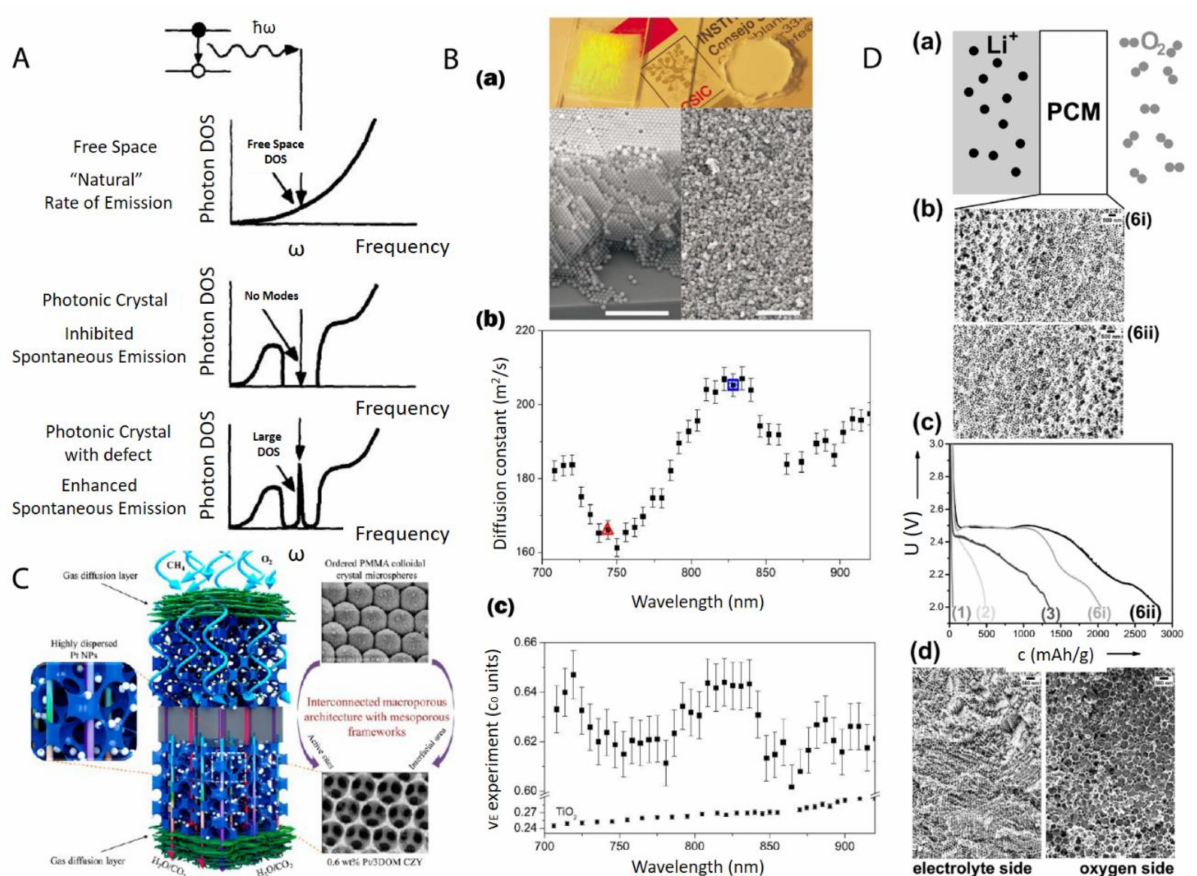
Figure 15. ( A ) Photon density of states (DOS) in free space, a photonic crystal, and a photonic crystal with a local defect. A perfect photonic crystal inhibits spontaneous photon emission within a band gap centered at a frequency ω while the spontaneous photon emission can be enhanced dramatically at frequency ω by a localized point defect in the colloidal crystal; ( B ) ( a ) Top: picture shows a photonic crystal (left), which shows visible iridescences and a photonic glass (right) white and without any iridescences. Bottom: Left is the SEM image from a photonic crystal (scale bar is 10 µ m) while Right is the SEM image from a photonic glass (scale bar is 10 µ m); ( b ) Experimental diffusion constant in a photonic glass made of PS spheres. Two particular wavelengths are marked with a triangle ( λ 1 = 744 nm) and a square ( λ 2 = 828 nm). These two wavelengths correspond to the maximum and minimum value of a Mie resonance; ( c ) Experimental values of the energy velocity ( ν E ) as a function of the wavelength ( λ ) for a photonic glass made of PS spheres and for TiO 2 powder. For the photonic glass, a full oscillation of around 5% amplitude is illustrated, while for the TiO 2 powder, a flat velocity dispersion is illustrated; ( C ) Schematic picture of a highly efficient catalysis system for methane combustion, which is composed of Pt nanoparticles embedded in latex nanoparticle-templated macroporous structures; ( D ) ( a , b ) porous gradient material-based Li-O 2 battery testing setup; ( c ) different Li-O 2 electrochemical discharge curves by using different gradient pore sizes; ( d ) SEM image of a typical porous gradient structure after charging/cycling. Reproduced with permission from